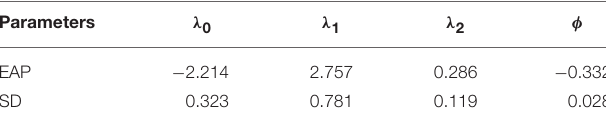
TABLE 3 | The MCMC parameter estimates for the transition model and φ from the response time model.